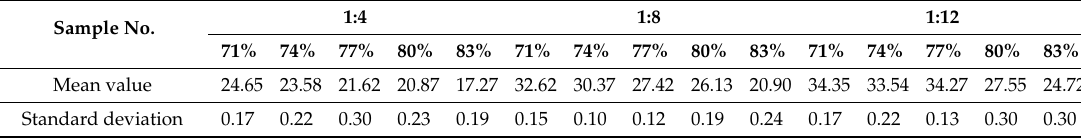
Table 2. The saturated porosity of backfills with di ff erent concentrations and ratios. Sample No.